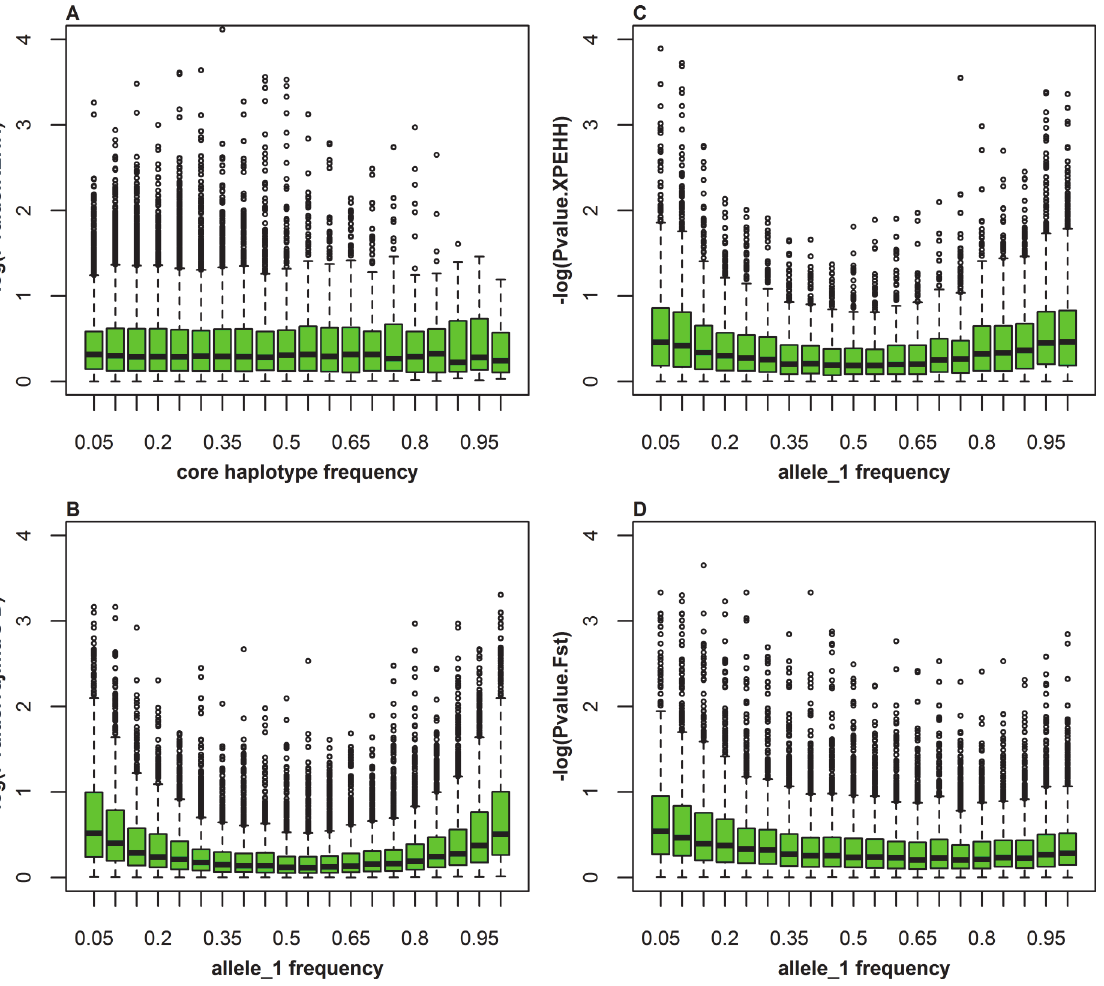
Figure 3. Distribution of – log(P-values) vs. haplotype/allele_1 frequency bins of 5% difference in Rongchang. Allele_1 is one assigned allele in each